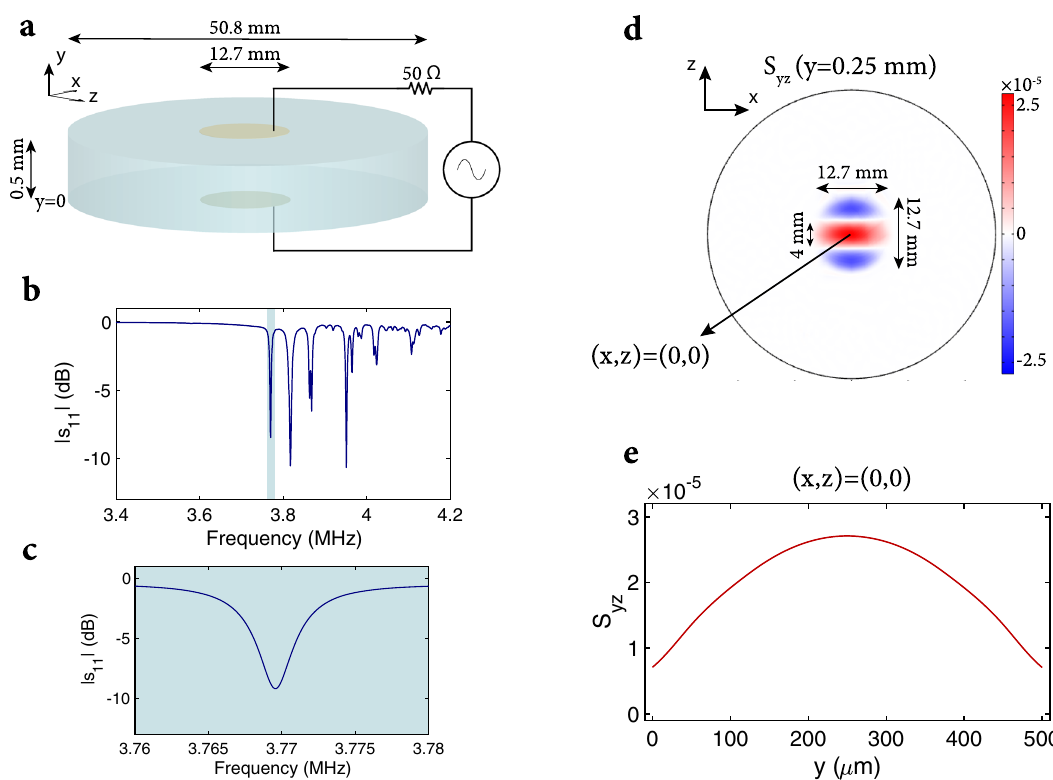
Fig. 1 Exciting the correct acoustic mode of the wafer. a A Y-cut lithium niobate wafer of diameter 50.8mm and of thickness 0.5 mm is coated on top and bottom surfaces with electrodes having a diameter of 12.7 mm. The wafer is excited with an RF source through the top and bottom electrodes. b Simulated ∣ s ∣ of the wafer with respect to 50 Ω , showing the resonances corresponding to different acoustic modes of the wafer (loss was added to lithium niobate 11 to make it consistent with experimental results). The desired acoustic mode appears around 3.77 MHz and is highlighted in blue. c The desired acoustic mode ∣ s 11 ∣ with respect to 50 Ω is shown in more detail. d The dominant strain distribution ( S yz ) when the wafer is excited at 3.7696 MHz with 2 Vpp is shown for the center of the wafer. This strain distribution corresponds to the ∣ s 11 ∣ resonance shown in ( c ). e The variation in S yz parallel to the wafer normal and centered along the wafer is shown when the wafer is excited at 3.7696 MHz with 2